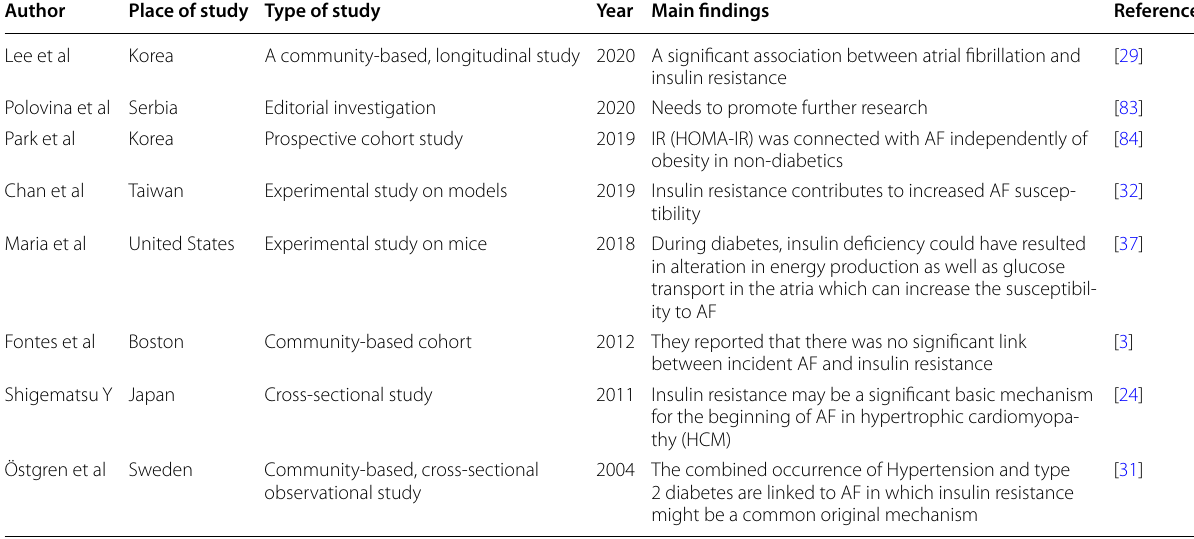
Table 1 Studies showing Insulin Resistance (IR) role in Atrial Fibrillation